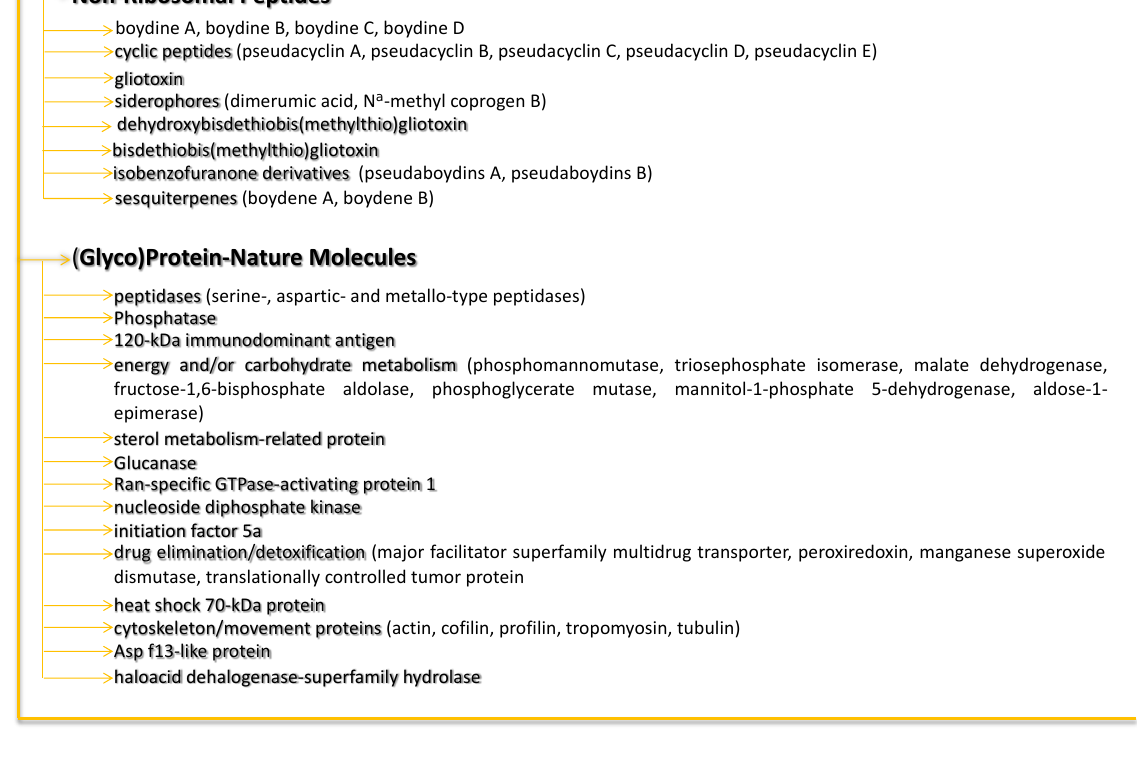
Figure 3. Overview of the different classes of molecules secreted/released by environmental and/or clinical strains of Scedosporium species.